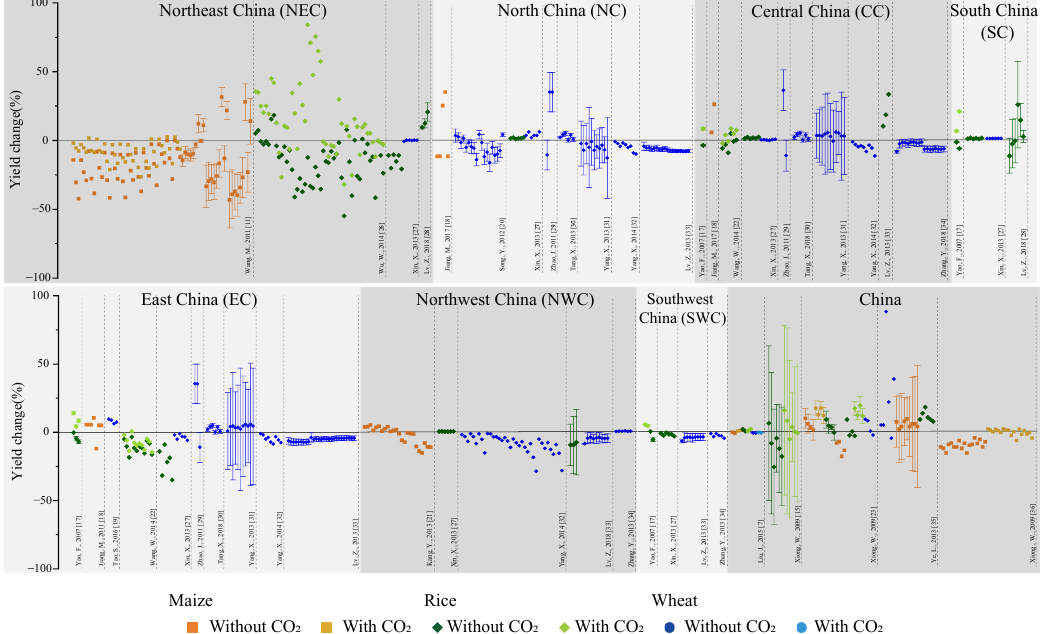
Figure 2. Summary of sample values of conclusion from selected articles (SAs) [7,11,15,17–23,26–36] on yield changes in China and 7 regions. (This figure shows the conclusions from all SAs. Di ff erent symbols and colors represent di ff erent crops, and the shade of the color indicates whether the CO 2 factor was considered, as stated in the legend in the figure. The contents of the horizontal coordinate annotation are the researcher (sorted by the author’s initials) and the publication date of the article corresponding to the data in the figure. The ordinate represents the percent change in yield. Grayscale blocks represent individual study areas, corresponding to Figure